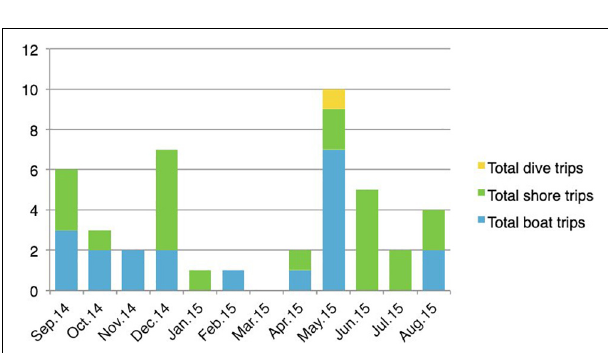
FIGURE 10 | Catch distribution by month of the migratory wahoo/kuta, Acanthocybium solandri (Data from Götesson, 2012).